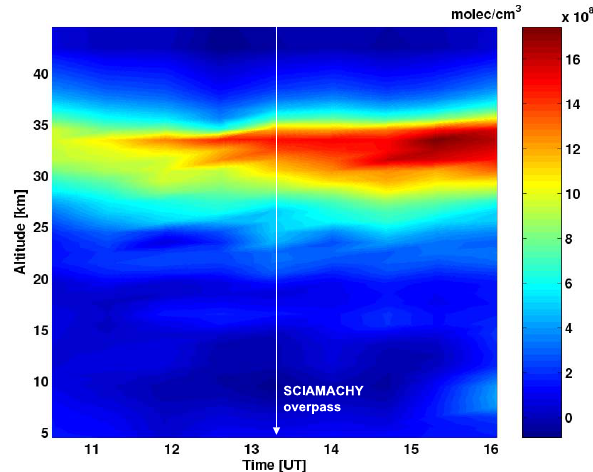
Fig. 8. Diurnal variation of NO 2 retrieved from mini-DOAS mea- Fig.8. Diurnal variation of NO 2 retrieved from mini-DOAS measurements aboard the LPMA/IASIpayload on surements aboard the LPMA/IASI payload on 30 June 2005. The June 30, 2005. The white arrow marks the time of the SCIAMACHY overpass. white arrow marks the time of the SCIAMACHY